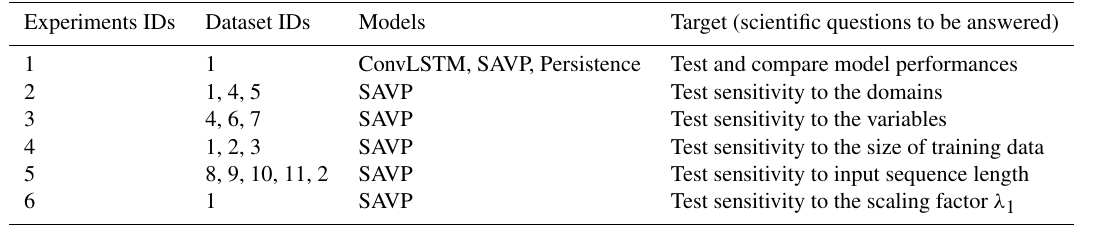
Table A2. Overview of the experiments in this